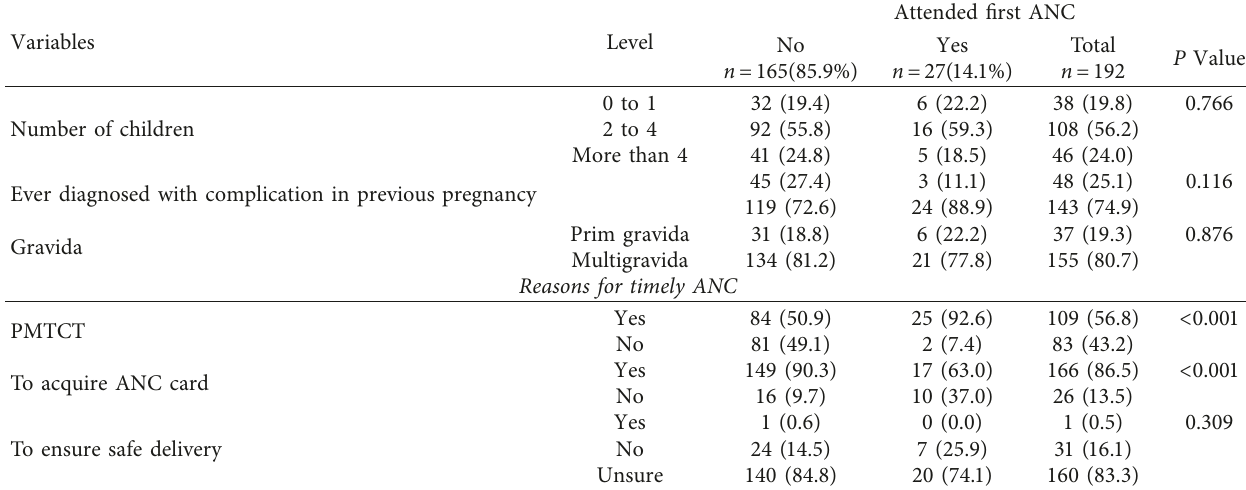
Table 3: Bivariate analysis of maternal factors and timely attendance of the first